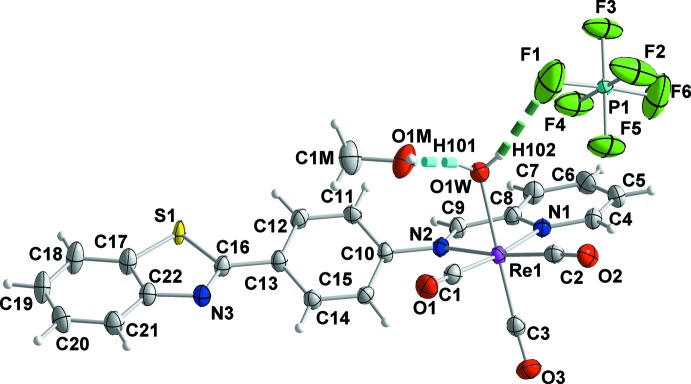
Mol­ecular structure and labeling scheme for the title ReI complex, the methanol solvent mol­ecule and the PF6
− counter-anion. Displacement ellipsoids are drawn at the 50% probability level. Cyan and dark-green dashed lines indicate the O1W—H101⋯O1M and O1W—H102⋯F1 hydrogen bonds, respectively.